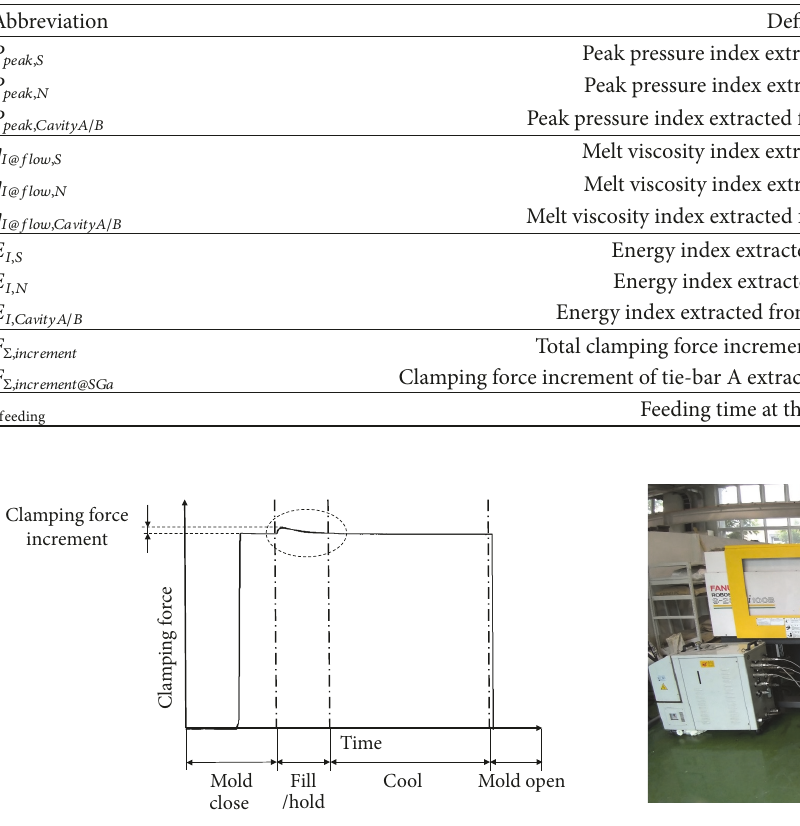
Figure 4: Photograph of experimental setup. Table 2: Correlation index categories